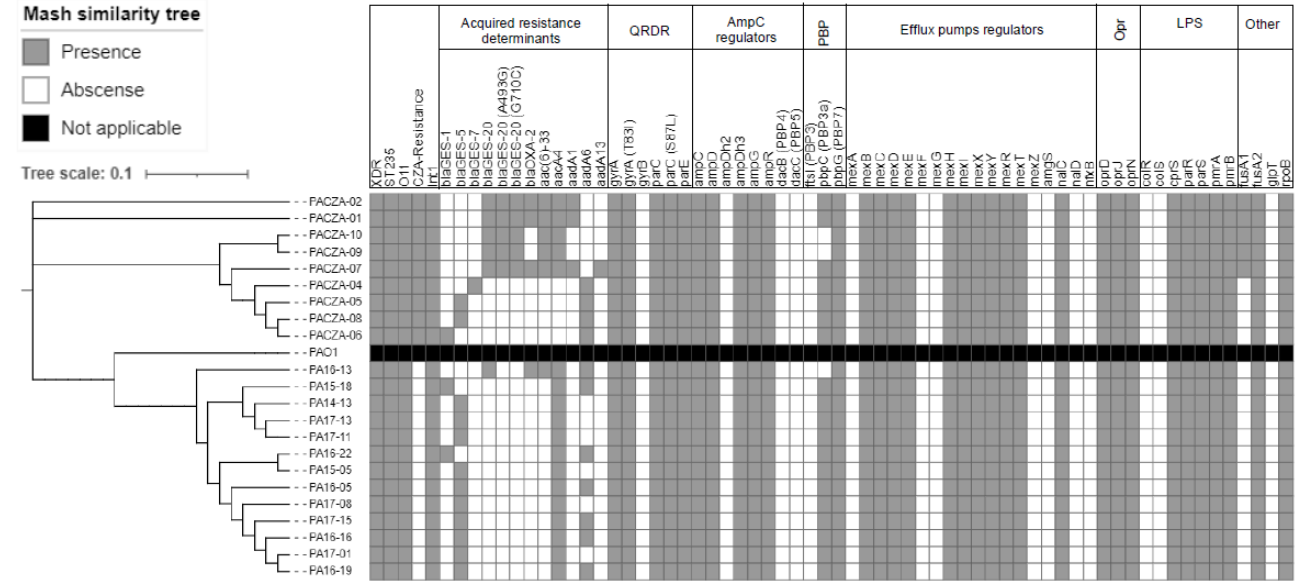
Figure 3. Mash similarity tree of the P. aeruginosa isolates analyzed by whole-genome sequencing. Main acquired and mutational genes involved in antimicrobial resistance are also included. Brach length is indicative of the Mash distance. QRDR, quinolone-resistance-determining region; PBP, penicillin-binding protein; LPS, lipopolysaccharide; XDR, extensively drug-resistant; ST, sequence type; CZA, ceftazidime/avibactam.